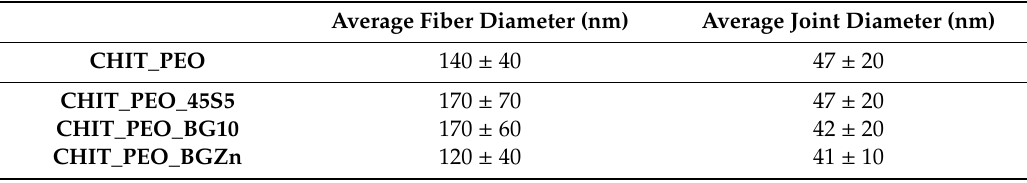
Table 3. Summary of the average fibers’ diameter and the average of joints diameter.